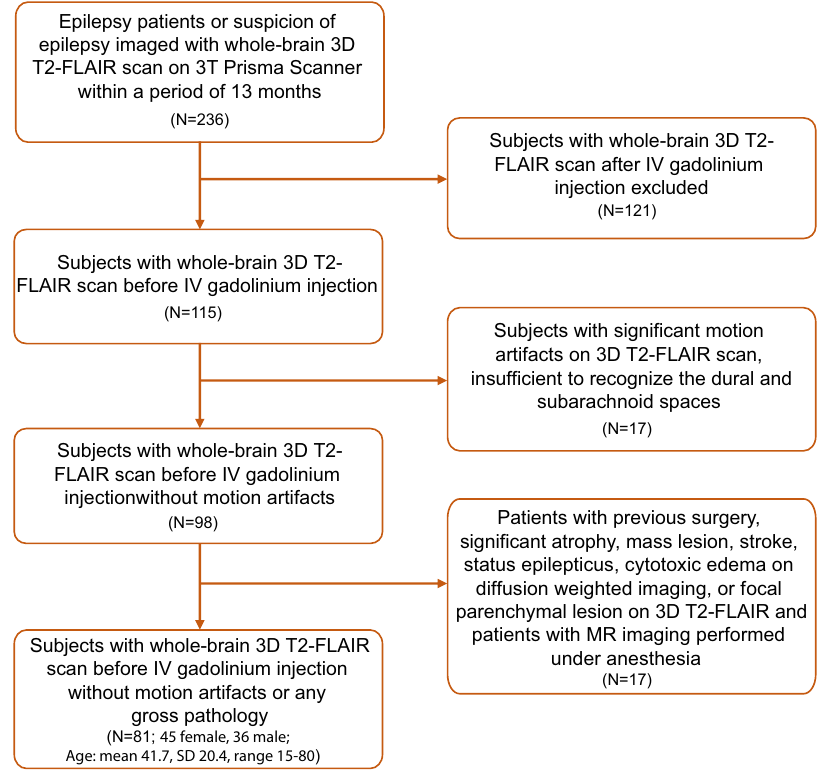
Fig. 2 Study pro fi le describing the patient selection process. In this fi gure, application of our inclusion and exclusion criteria to the study population is represented in detail. SD, standard